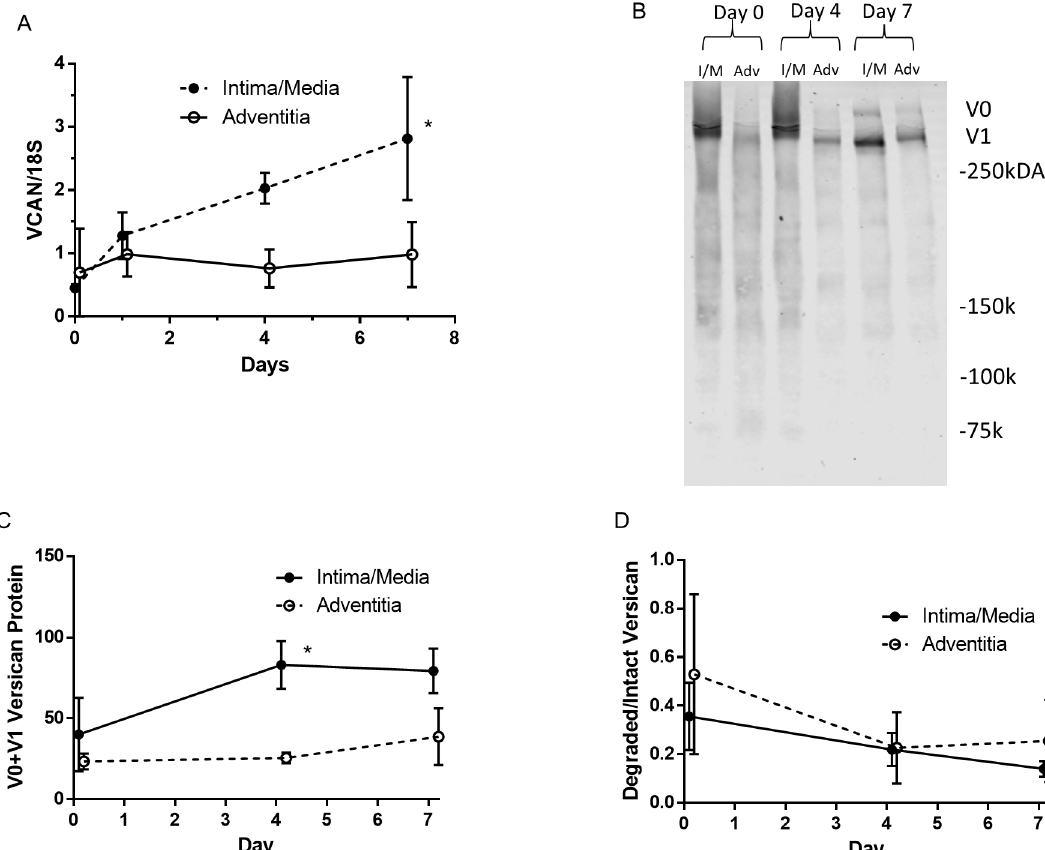
Fig 3. Versican induction in intimal/medial vs. adventitial tissue. Induction of versican message and protein in floating intimal/ medial and adventitial tissue. (A) Versican mRNA ( (cid:3) P < 0.02 intima/media vs. adventitia. N = 3 veins day 0, N = 6 veins days 1–7). (B) Versican western blot of tissue from one vein (“int/med” intima/media and “adv” adventitia. (C) Quantification of V0/V1 versican protein ( (cid:3) P < 0.02 intima/media vs. adventitia mean gray value. N = 3 veins). (D) Quantification of versican degradation products (75–250 kD) relative to intact V0/V1 versican (N = 3